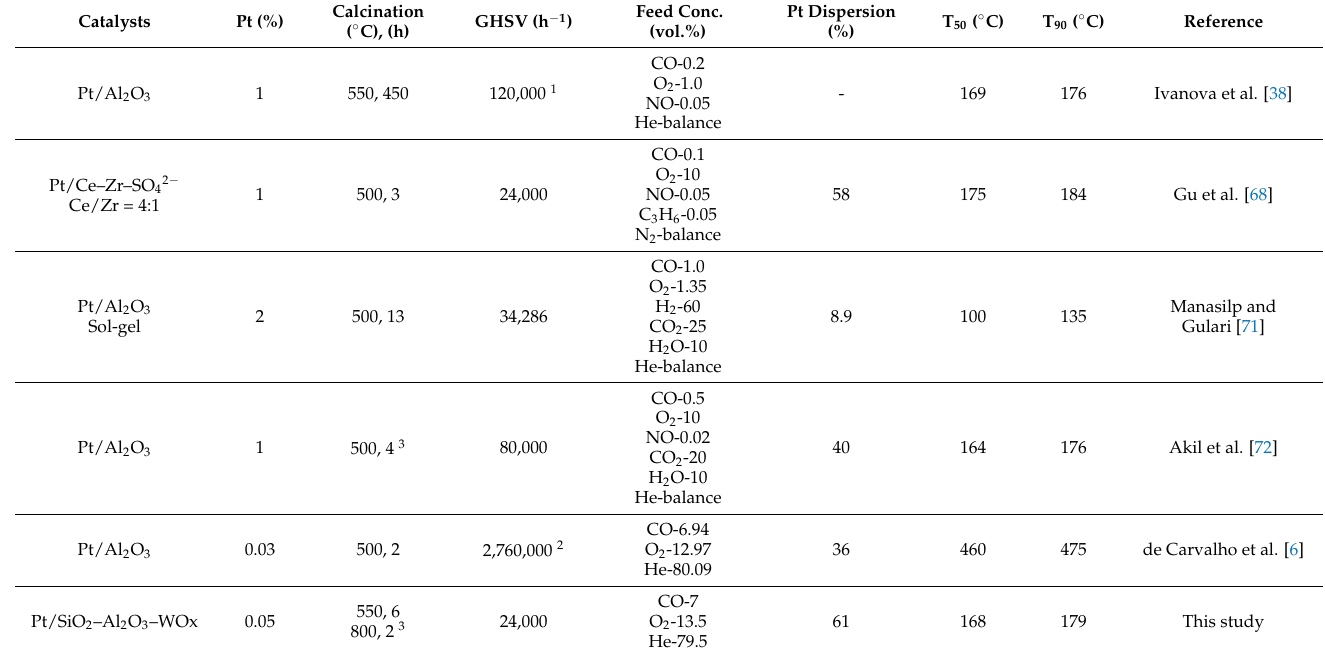
Table 6. Comparison of CO combustion studies with catalysts containing